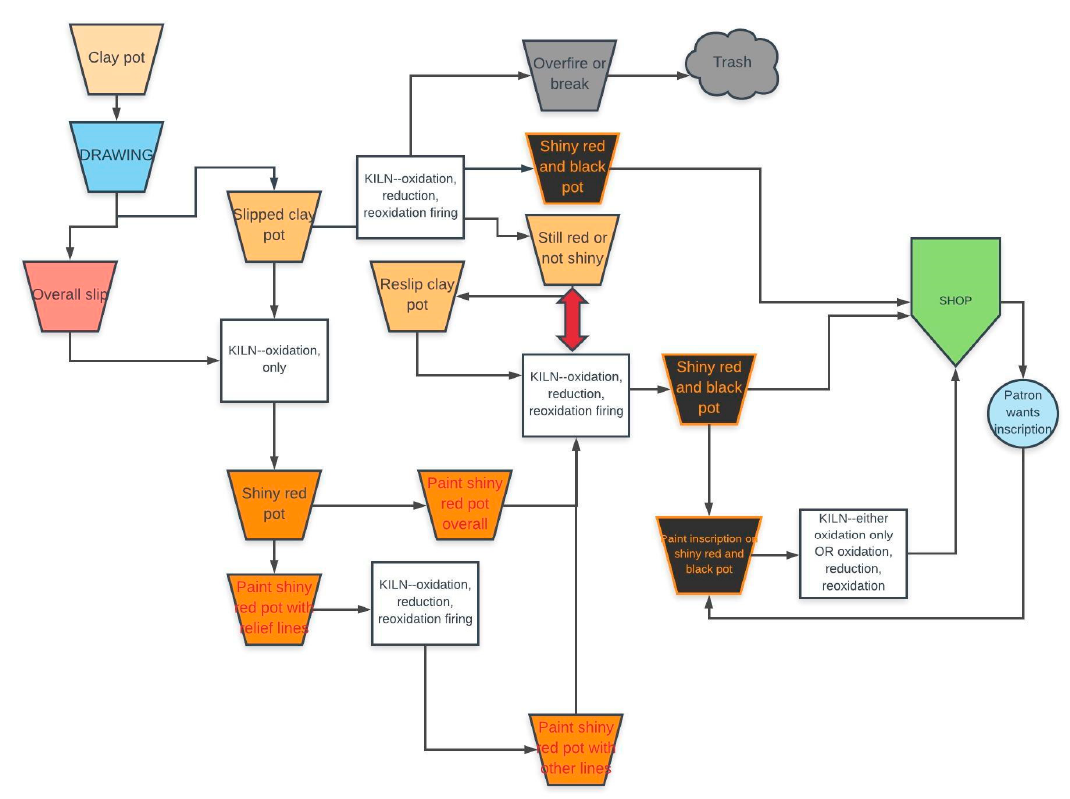
Figure 3. Multiple pathways for producing red and black ceramics, as tested experimentally.